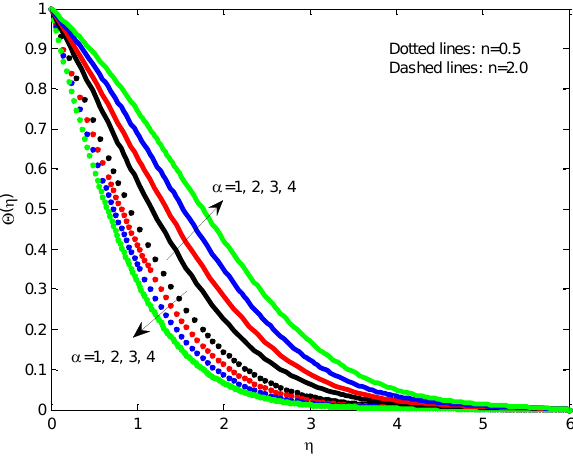
Figure 4. Effect of  on ( )  .